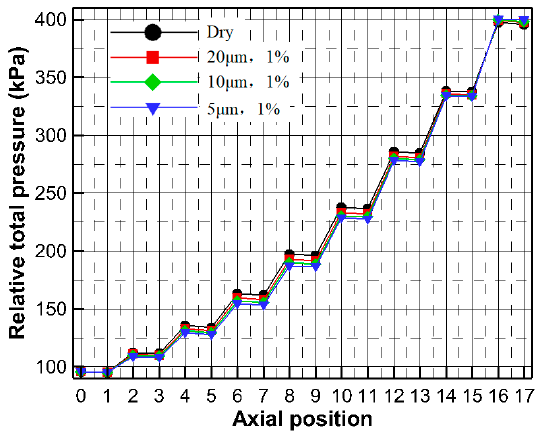
Figure 27. Axial variation of relative total pressure under injecting water of different droplet sizes.